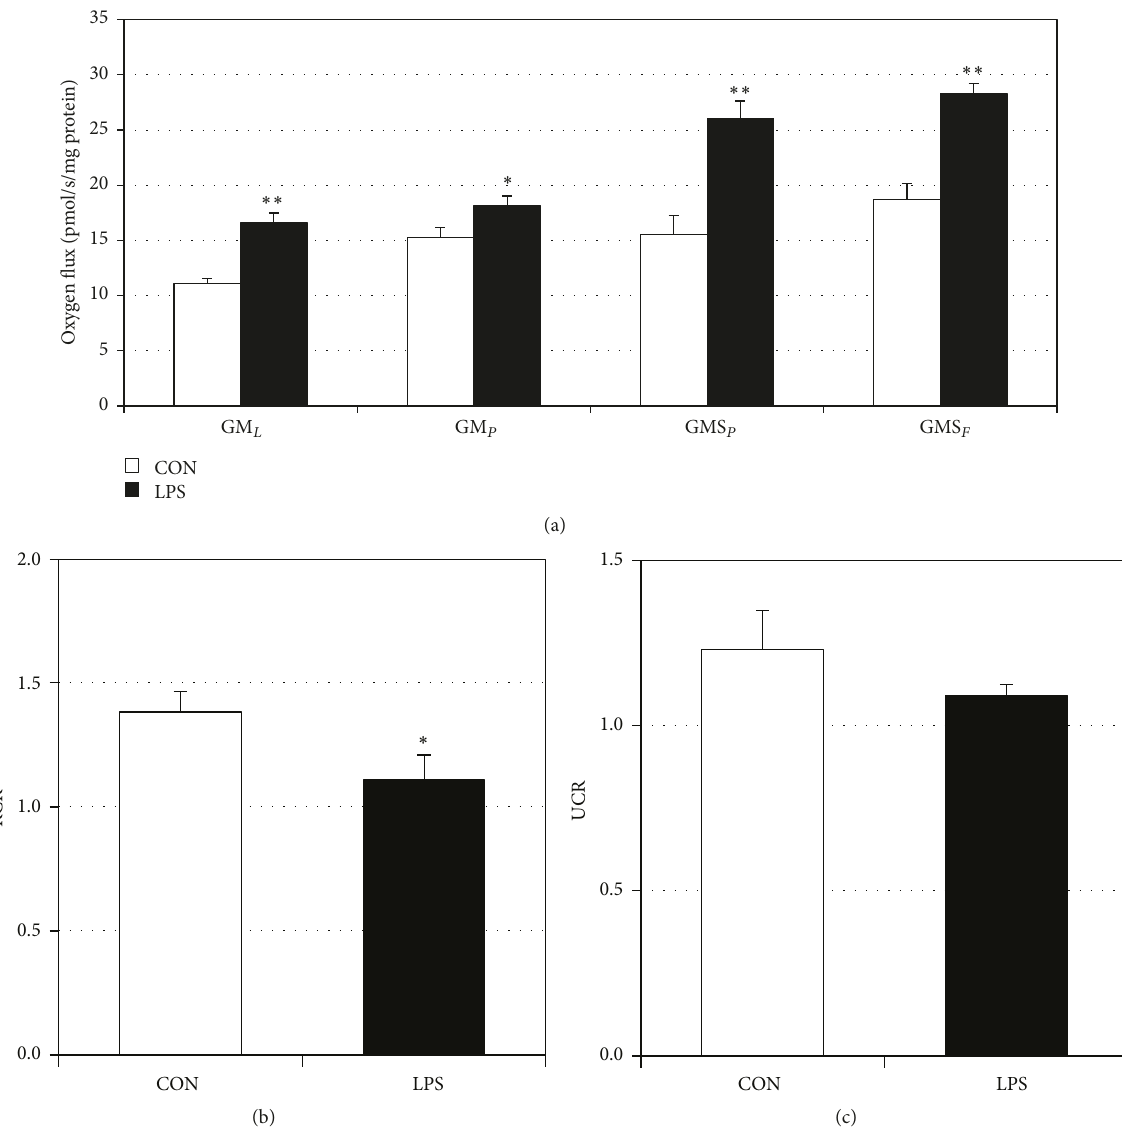
Figure 2: LPS alters HGF-1 mitochondrial bioenergetics. Mitochondrial assessments were determined in permeabilized (digitonin, 1mg/mL) HGF-1 cells following treatment with LPS (5 𝜇 g/mL) for 48 h. To measure mitochondrial respiration (a), samples were sequentially treated with GM (glutamate (10mM) + malate (2mM)), GMP (glutamate (10mM) + ADP (2.5 mM)), GMS (glutamate (10mM) + succinate L P P (10mM)), and GMS (glutamate (10mM) + FCCP (0.05 𝜇 M)). Respiratory control ratio (RCR, (b)) and uncoupling control ratio (UCR, (c)) F were determined by the analysis indicated in the Methods ( 𝑛 = 4 ). ∗ 𝑃 < 0.05 ; ∗∗ 𝑃 < 0.01